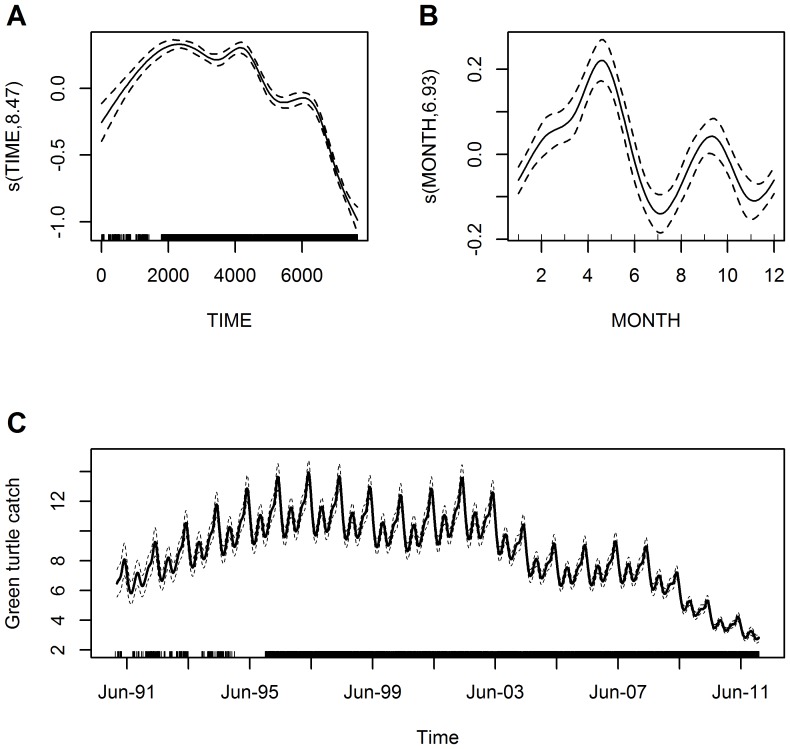
Overall trend in green turtle catch rates for the Caribbean coast of Nicaragua.Estimated conditional dependence of catch rates from 1991 to 2011 for (A) time and (B) month. Plot components are: estimates on the scale of the linear predictor (solid lines) with the y-axis scale for each variable selected to optimally display the results, confidence intervals (dashed lines), and explanatory variable values of observations shown as a rug plot along each x-axis. Also shown on the scale of the response is (C) trend in catches (average turtles/day) over time from 1991 to 2011, assuming average fishing effort for this period in terms of nets used and trip length. The seven principal fishing communities included in the analysis are: Awastara, Dakura, and Sandy Bay in the RAAN; Río Grande Bar, Sandy Bay Sirpi, Set Net Point, and Tasbapauni in the RAAS.